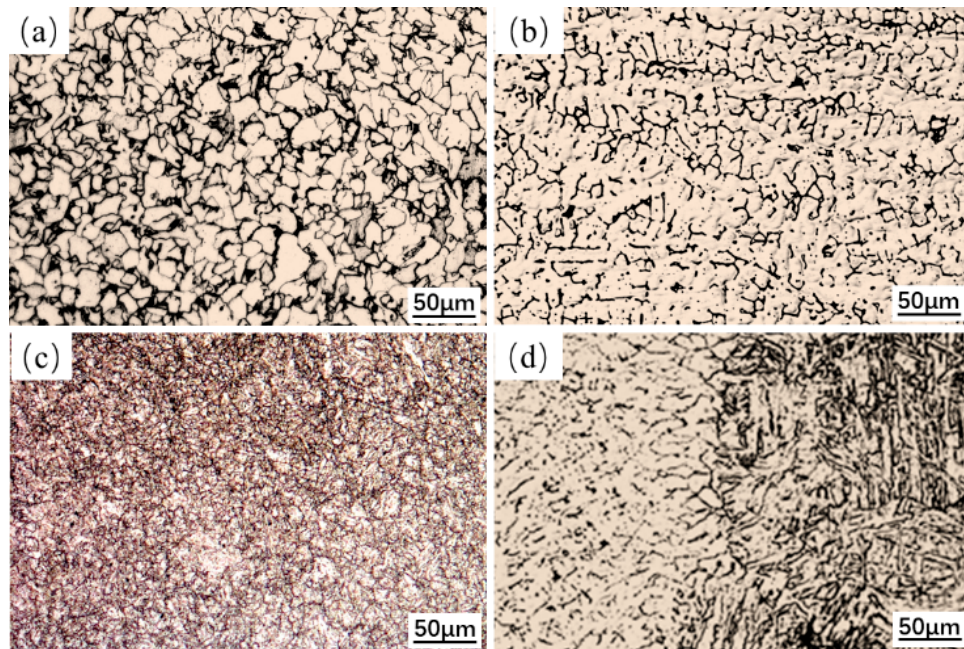
Figure 4. Optical microstructures of samples. ( a ) Sample 1: Q345, ( b ) sample 2: 308, ( c , d ) sample 3 and 4, respectively.